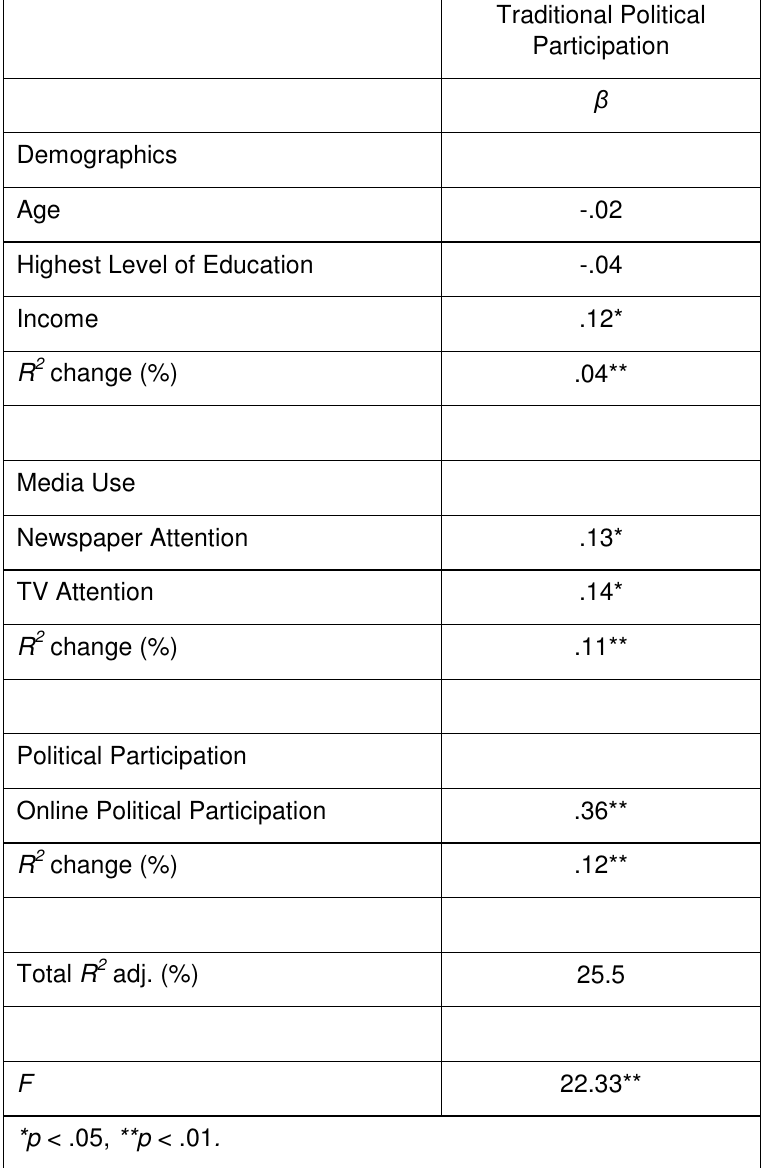
Table 2: Hierarchical Regressions Predicting Traditional Political Participation from Demographic, Media Use Variables, and Online Political Participation (n =